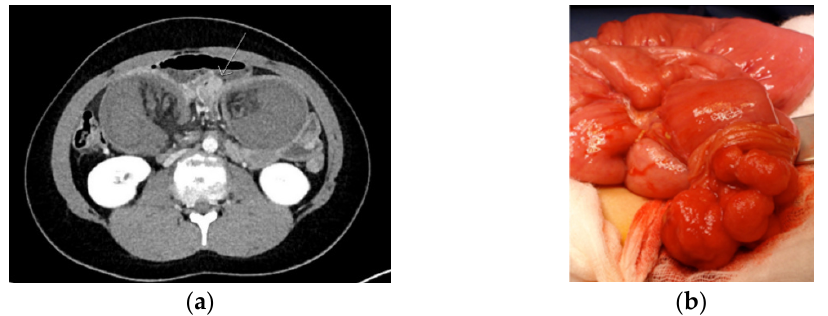
Figure 2. CT image of intussusception ( a ) and to be resected polyp ( b ) in a Peutz–Jeghers syndrome patient.